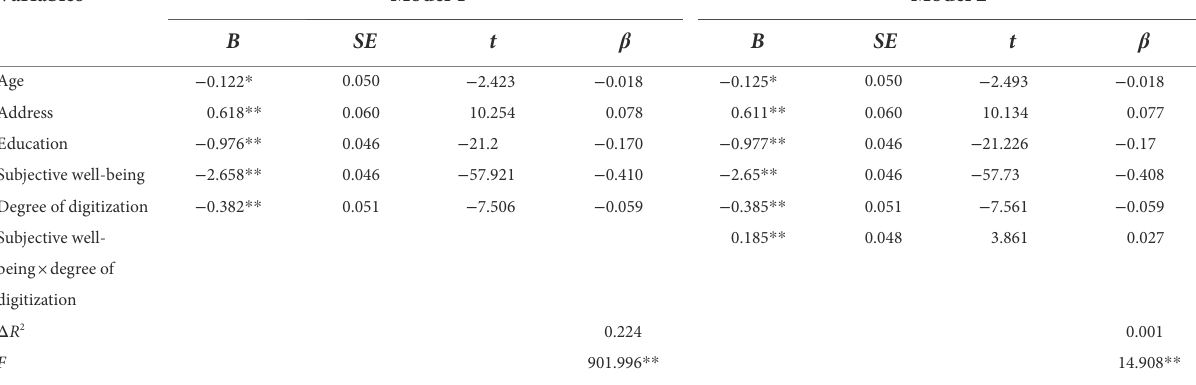
TABLE 7 The moderating effect test of degree of